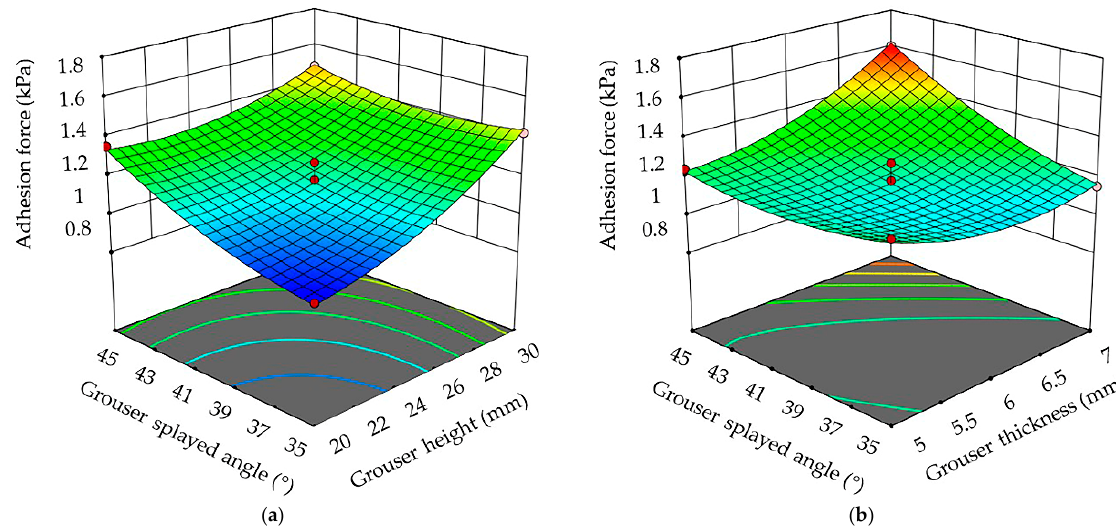
Figure 4. 3D response surface diagram of pairwise interaction of the grouser height, grouser thickness, and grouser splayed angle on adhesion force. ( a ) Interaction of grouser height and grouser splayed angle; ( b ) interaction of grouser thickness and grouser splayed angle.